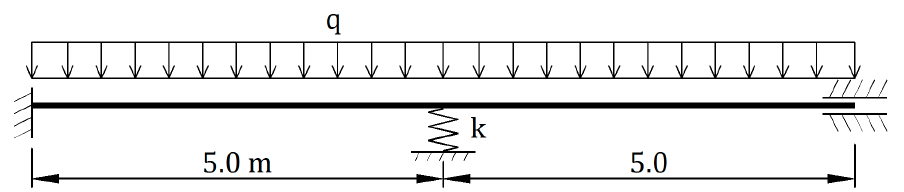
16 of 25 Figure 15 . P (cid:2919) (u (cid:2919) ) graph (i = 1—red; i = 2—green; i = 3—blue). Graphs in Figure 16 show the relation between σ (cid:2919) stresses [MPa] and ε (cid:2919) strains. It can be seen that the load curves for bars no. 1 no. 3 overlap (partly as more stress is achieved in bar no. 3), while the curve for bar no. 2 is more inclined. This is also the case during the relief stage. It is caused by different stiffness of the materials from which the bars are made. Figure 16. σ (cid:2919) (ε (cid:2919) ) graph (i = 1—red; i = 2—green; i = 3—blue). The presented example differs from the previous ones as its solution required solving a system of non-linear equations. Based on the achieved results, it was concluded that: •